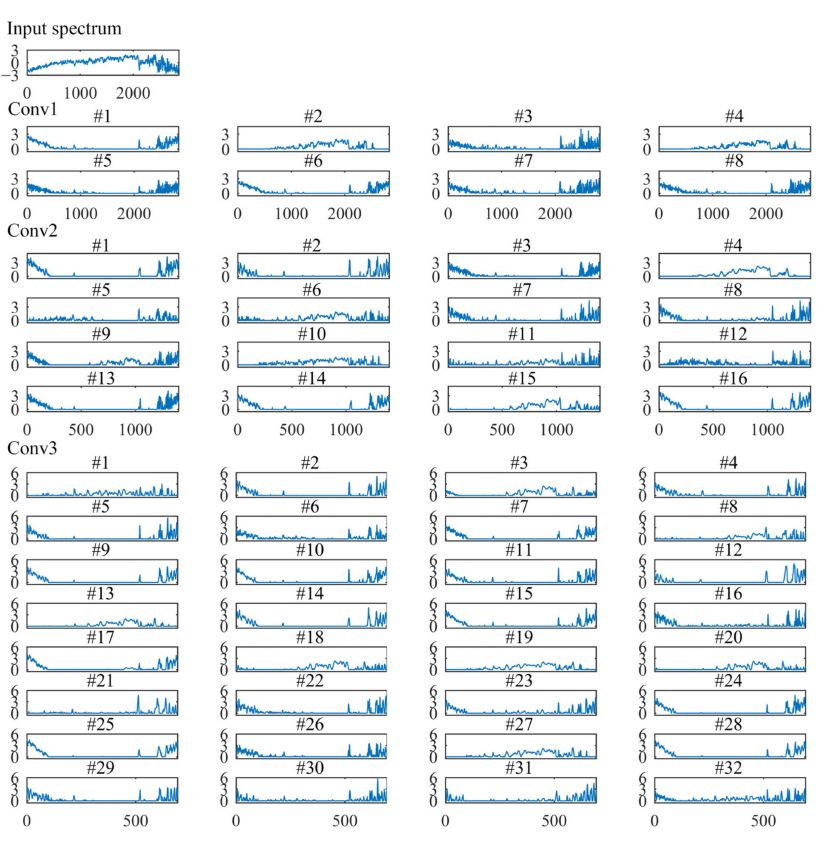
Figure 7. Visualization of the input spectral and feature maps of each convolutional layer for the grating spectrograph experiment.